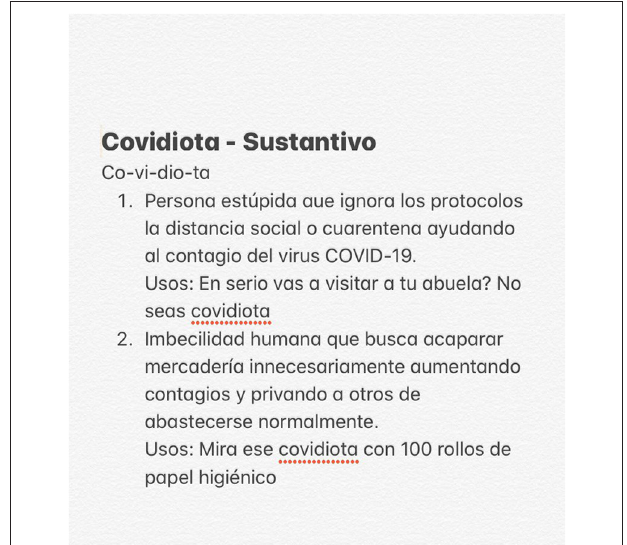
FIGURE 2 | Spanish definition of covidiota shared on Twitter (https://pbs. twimg.com/media/ETuYeEdXQAEld52?format=jpg&name=900x900).